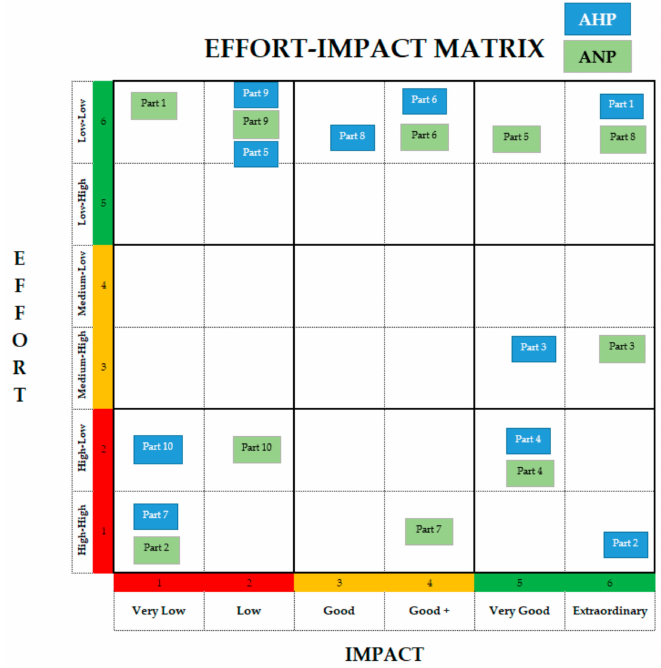
Figure 9. Effort–impact